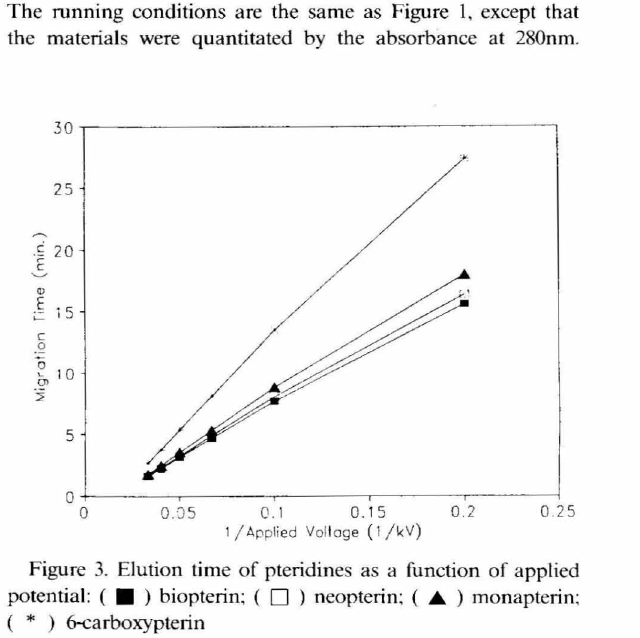
Figure 2. Effect of ionic strength on the electropherogram. Upper : pteridine mixture in D.W. Lower : pteridine mixture in O.l5M NaCI I, biopterin; 2, neopterin; 3, monapterin; 4, ~arboxypterin